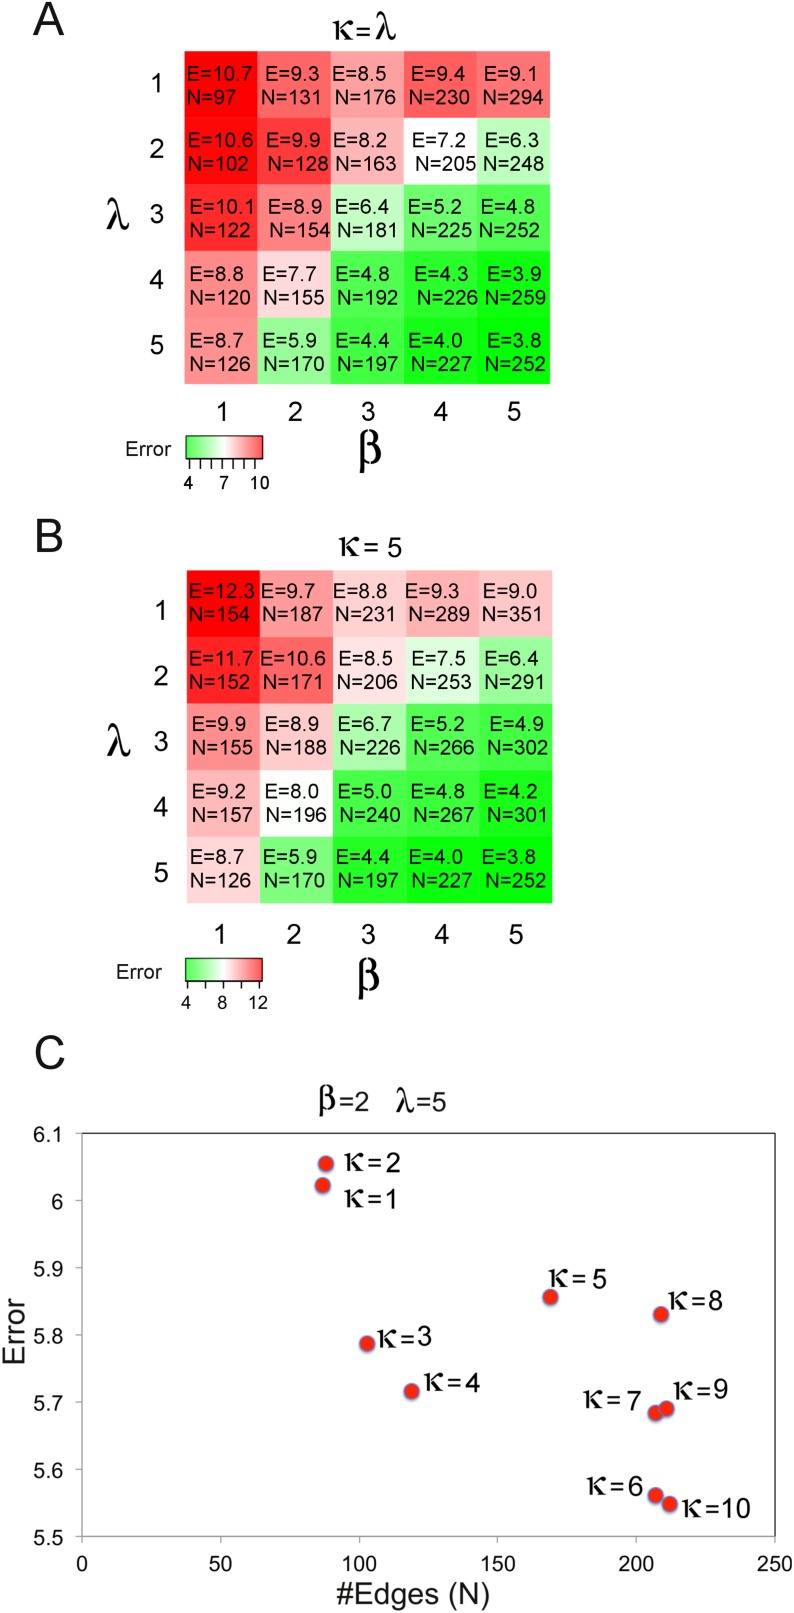
Optimization of network inference cost function parameters.We performed an error and connectivity analysis of BP-generated models with varying cost function parameters (sum-of-squares error [SSE]: β, model complexity: λ, prior information: κ). The network models are generated using the SkMel-133 proteomic/phenotypic response data and the BP-based inference method as in Figure 4—figure supplement 3. The SSE and model complexity (number of edges in the model) are calculated for each inferred model. We searched for the inference parameters that lead to low SSE and an intermediate model complexity (e.g., 1.5 < [(#edges)/(#nodes)] < 2.0). (A) The β and λ is incremented systematically while κ = λ. A low SSE with a desired connectivity level is reached for β = 2, λ = 5 and κ = 5. For different parameter sets, we obtained lower errors only for extremely connected networks inferred with high β values and so with a high weight on error in BP-optimization (e.g., β = 5, λ = 5, κ = 5, SSE = 3.8, #edges = 252). (B) The β and λ is incremented while κ is fixed (κ = 5) to determine the optimum solution with better SSE and connectivity level for (κ = 5). The parameter set, β = 2 and λ = 5 yielded the most desired SSE and connectivity values. (C) The κ is incremented for fixed β and λ (β = 2, λ = 5). The error is relatively insensitive to variations in κ as the final error is in the range of 5.6–6.1 for different κ values, although the connectivity increases with increasing prior strength in the cost function. This suggests that the error is mainly driven by the global β and λ terms at least around the tested β and λ values. Increasing κ, which is nonzero for only a small fraction (<2%) of possible interactions in the model, may enforce an increase in number of nonzero edges with an incremental effect on the error. κ = 5 yielded a desired connectivity value with a sufficiently low SSE. We used the parameter set (β = 2, λ = 5, κ = 5) in all BP-guided decimation calculations with the SkMel-133 data.